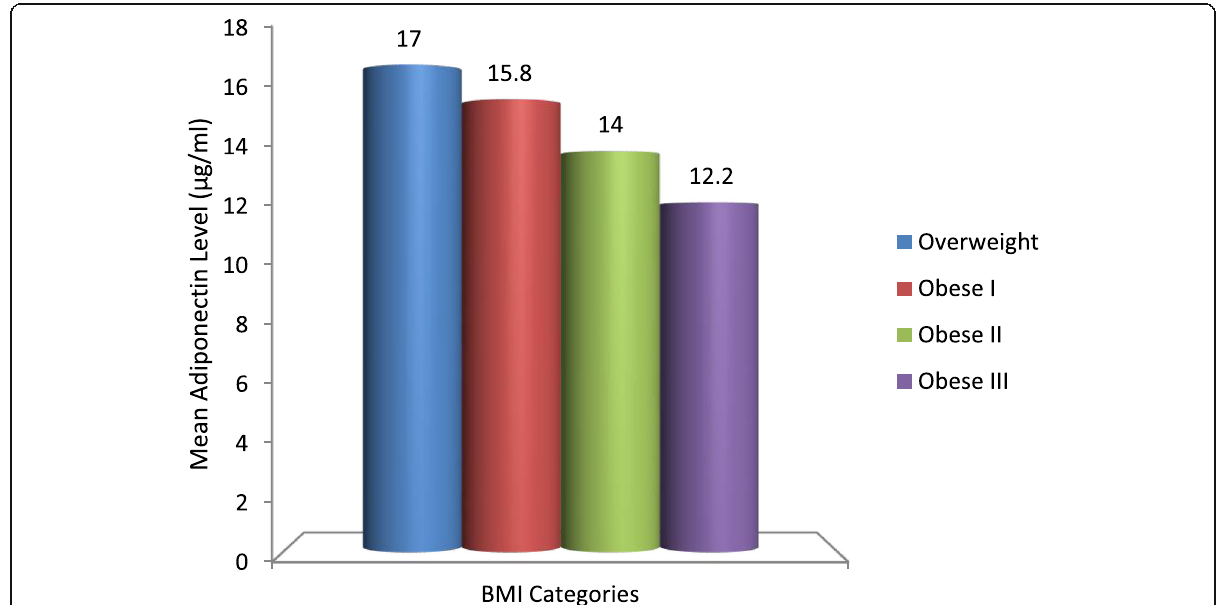
Fig. 1 The mean adiponectin level among the studied sample according to BMI categories